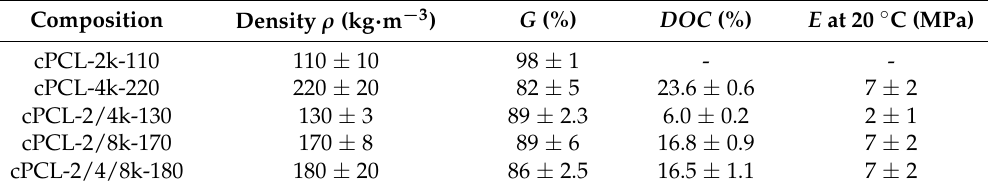
Table 3. Densities and gel content values for obtained compositions. DOC : weight percent crystallinity; G : gel content; E : E